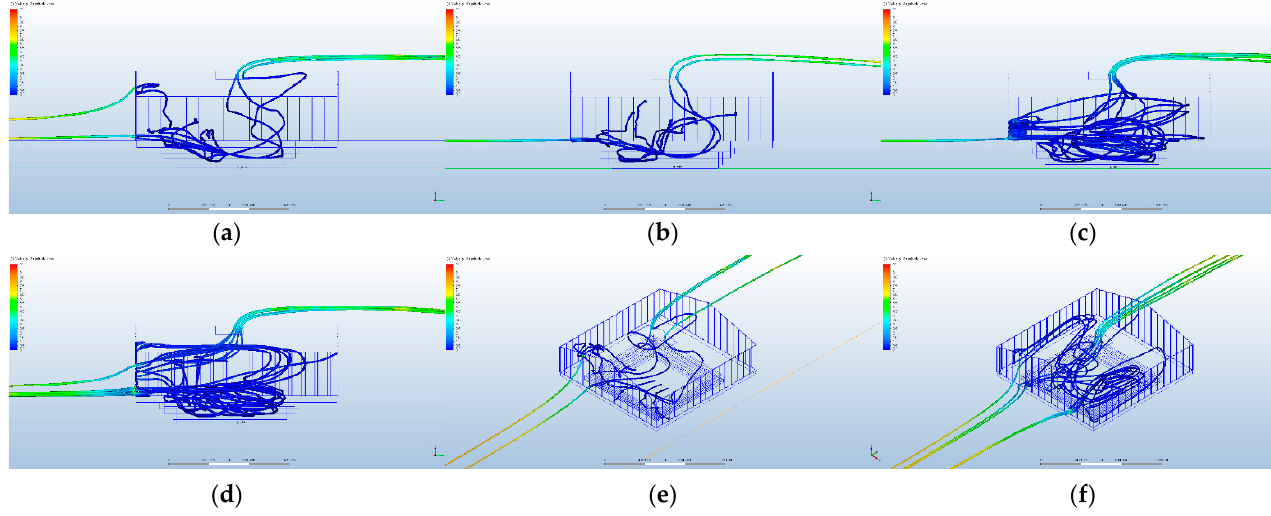
Figure 12. Airflow traces in the pit when the smoke hole is opened. ( a ) 1 cm gap; ( b ) 2 cm gap; ( c ) 3 cm gap; ( d ) 4 cm gap; ( e ) Axonometry corresponding to ( a ); ( f ) Axonometry corresponding to ( d ) (Autodesk CFD ® ).